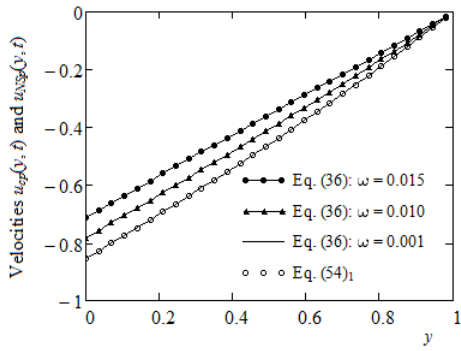
Figure 1. Convergence of the long-time velocity u cp ( y , t ) given by Eq. (36) to the corresponding Newtonian